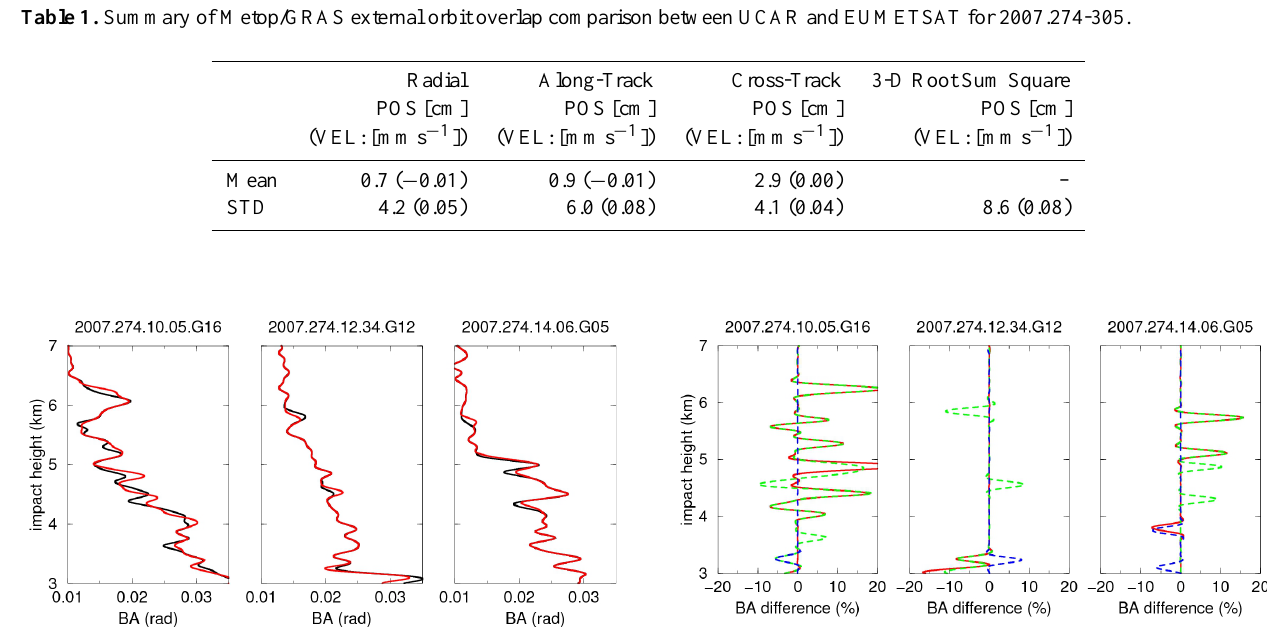
Fig. 7. L1 bending angles retrieved from Metop/GRAS raw sam- pling data for three tropical occultations by phase matching. Red and black lines correspond to retrieval from 1000Hz samples and from 50Hz samples (after down-sampling).